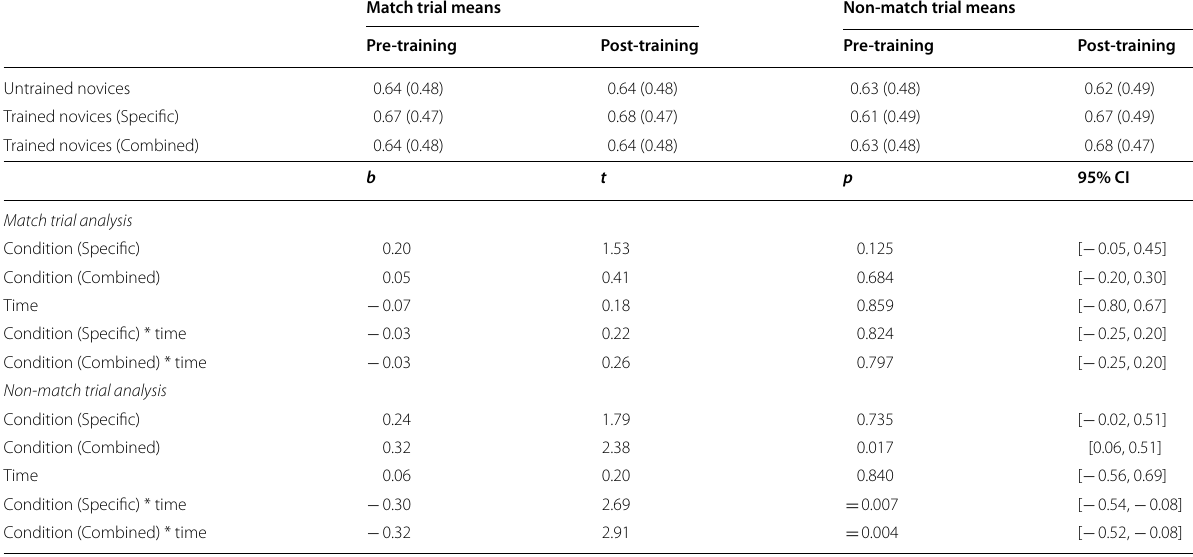
Table 2 Means, standard deviations (in brackets), and analyses on match and non-match trials pre-training and post-training between conditions in Experiment 2 Match trial